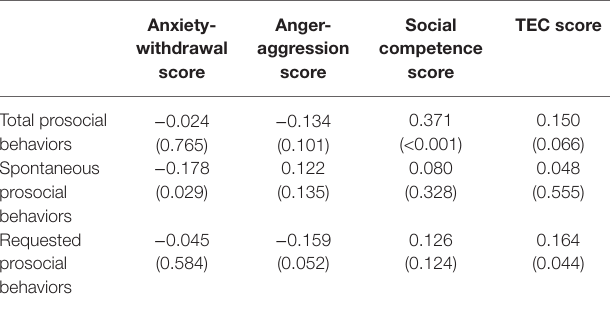
TABLE 3 | Pearson partial correlations performed between prosocial and social- emotional and behavioral measures (values of p in brackets). Anxiety-